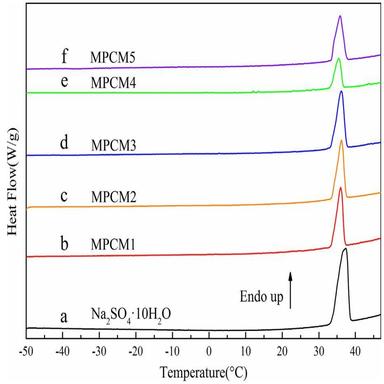
Melting DSC curves of (a) Na2SO4·10H2O and (b–f) MPCM1–MPCM5.